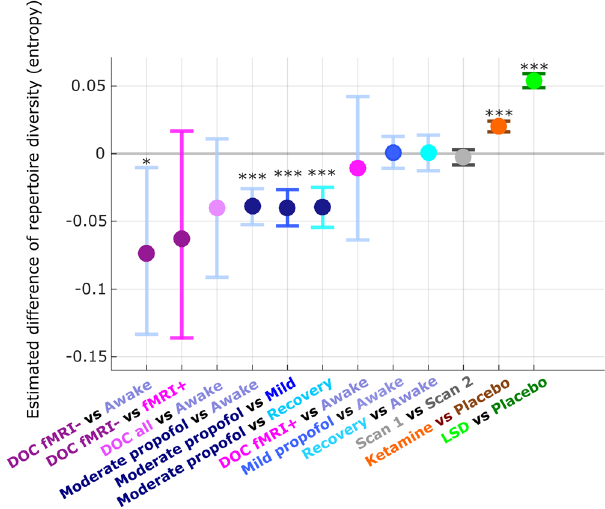
Fig. 5 Diversity of connectome harmonic repertoire tracks level of consciousness from loss of responsiveness to psychedelics. Pairs of conditions (states of consciousness) were compared with linear mixed effects modelling, by treating condition as a fi xed effect and subjects as random effects. Timepoints were also included as random effects, nested within subjects. Plot shows the statistical estimates ( fi xed effect of condition) for each contrast, and error bars indicate the 95% CIs, from the LME model. At every timepoint t i , the contribution of each connectome harmonic to the overall pattern of brain activity is quanti fi ed by the (cid:1) (cid:1) (cid:1) (cid:1) . Note that no binning was used for this harmonic power: P ð φ k ; t i Þ ¼ ω k ð t i Þ analysis. The diversity of the repertoire of harmonic power can then be quanti fi ed in terms of the entropy of the power distribution: the higher the “ harmonic repertoire diversity ” , the wider the range of connectome harmonics that are recruited to compose cortical activity. Data distributions of connectome harmonic repertoire for each condition are shown in Supplementary Fig. 9, and source data are provided in Supplementary Data 3. Wakefulness, mild sedation, moderate anaesthesia, and recovery: n = 15 subjects with 145 timepoints each, for each condition. DOC fMRI + patients: n = 8 subjects with 295 timepoints each; DOC fMRI − patients: n = 14 subjects with 295 timepoints each. Test-retest scan 1 and scan 2: n = 18 subjects with 155 timepoints each, for each condition. Ketamine and placebo: n = 20 subjects with 295 timepoints each, for each condition. LSD and placebo: n = 15 subjects with 435 timepoints each, for each